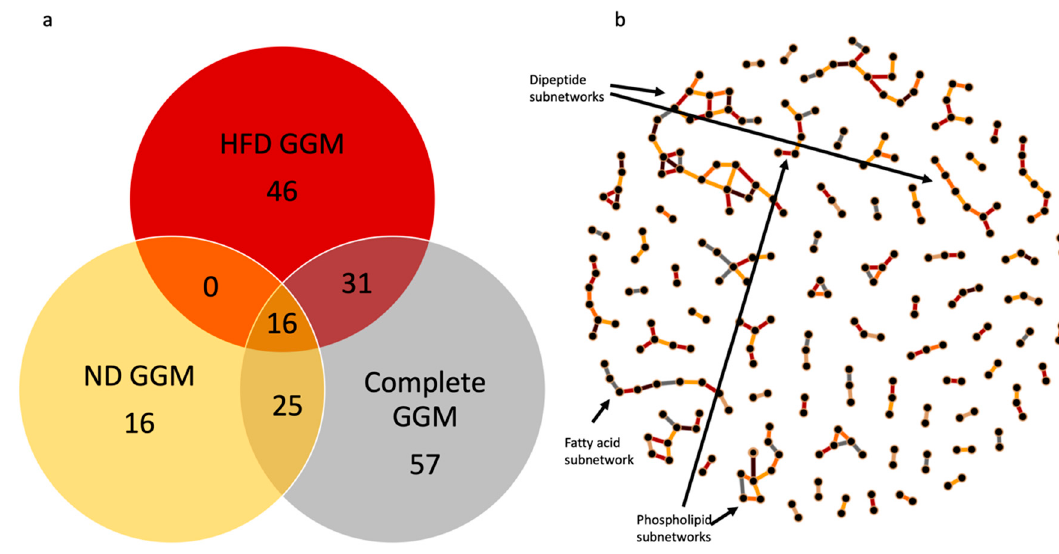
Figure 4. ( a ) Venn diagram showing the overlap of edges in the GGMs for the High fat diet (HFD), Normal diet (ND), and complete dataset GGMs. ( b ) The network shows the complete set of edges across all three models color coded to match the Venn diagram to specific which edges were determined from which models. (Interactive network visualization can be found in Supplemental Files: Figure_S4_all_edge_ggm.html.).